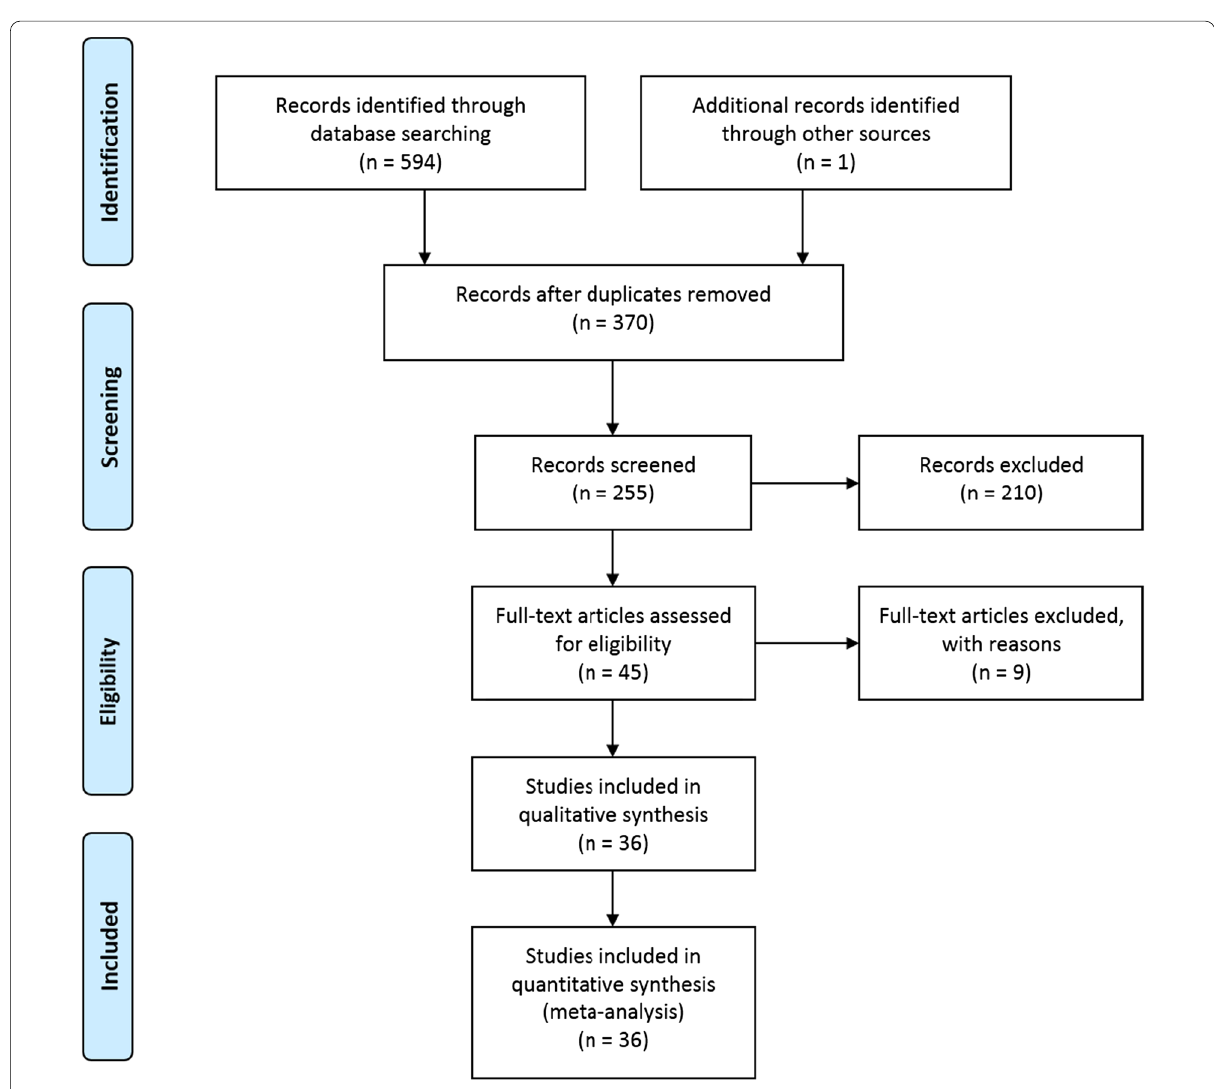
Fig. 1 PRISMA flow diagram for the searching procedure